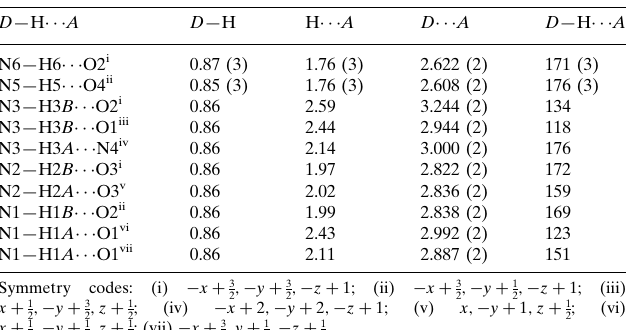
Hydrogen-bond geometry (A˚ , (cid:3)